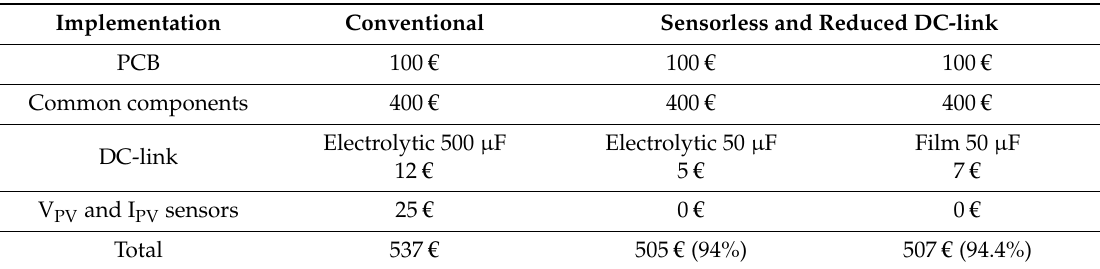
Table A1. Approximate costs of the